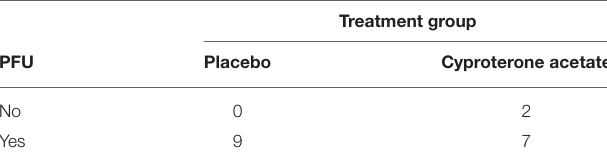
TABLE 6 | Numbers of subjects experiencing or not PFU in the two treatment groups.